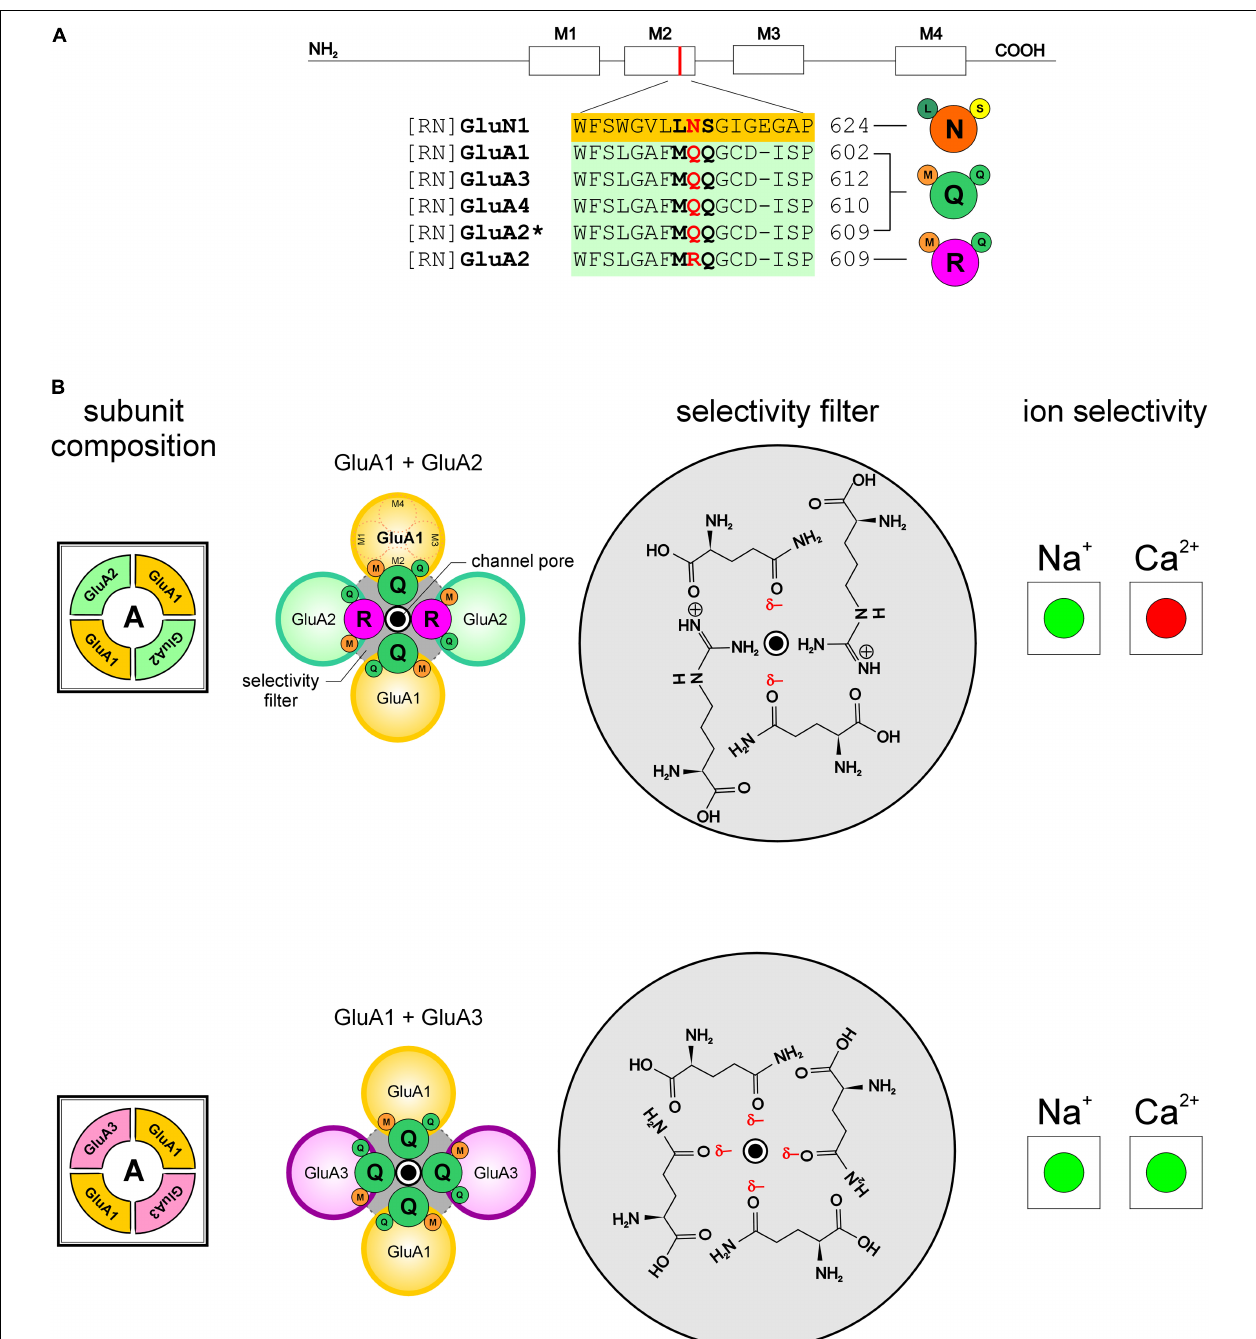
FIGURE 5 | Selectivity and permeability of cations in AMPARs is dependent on the GluA2 subunit and the sequence of amino acids that compose the selectivity filters in the pore-forming region of the receptor channels. (A) Predicted membrane helices (M1-M4) and M2 sequence alignment of GluN1; GluA1, A3, A4, and A2*, post-transcriptionally modified form of A2 from rat (RN, rattus norvegicus ). Amino acid residues determining functional channel properties are indicated in bold and conserved residues determining ion selectivity in red. Numbers refer to amino acid positions within subunits. Abbreviations for the amino acid residues are: A, Ala; C, Cys; E, Glu; F, Phe; G, Gly; I, Ile; K, Lys; L, Leu; N, Asn; P, Pro; Q, Gln; R, Arg; S, Ser; T, Thr; V, Val; W, Trp; and Y, Tyr. (B) Schematic arrangement of subunits and amino acid residues that constitute the putative selectivity filters in the identified AMPARs (A, left ), and their selectivity (enhanced, green; diminished, red) for Na + and/or Ca 2 + ions ( right ). Notice how the ring of partial negativity, arising from arrangement of partial negative charges ( δ –) on glutamine’s polar side chains, in the selectivity filter for GluA2-lacking AMPARs ( gray circle , bottom panel; ring charge, r q = –4) is altered following its incorporation into the subunit composition of the receptor ( gray circle , top panel r q =